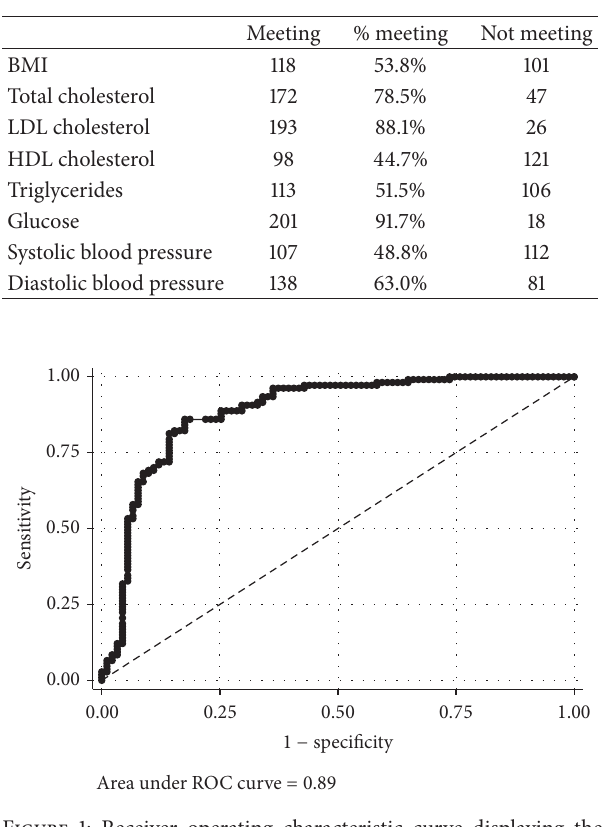
Figure 1: Receiver operating characteristic curve displaying the sensitivity and 1 − specificity scores for waist-to-height ratio cut- points associating with children meeting FITNESSGRAM’s body composition criterion-referenced